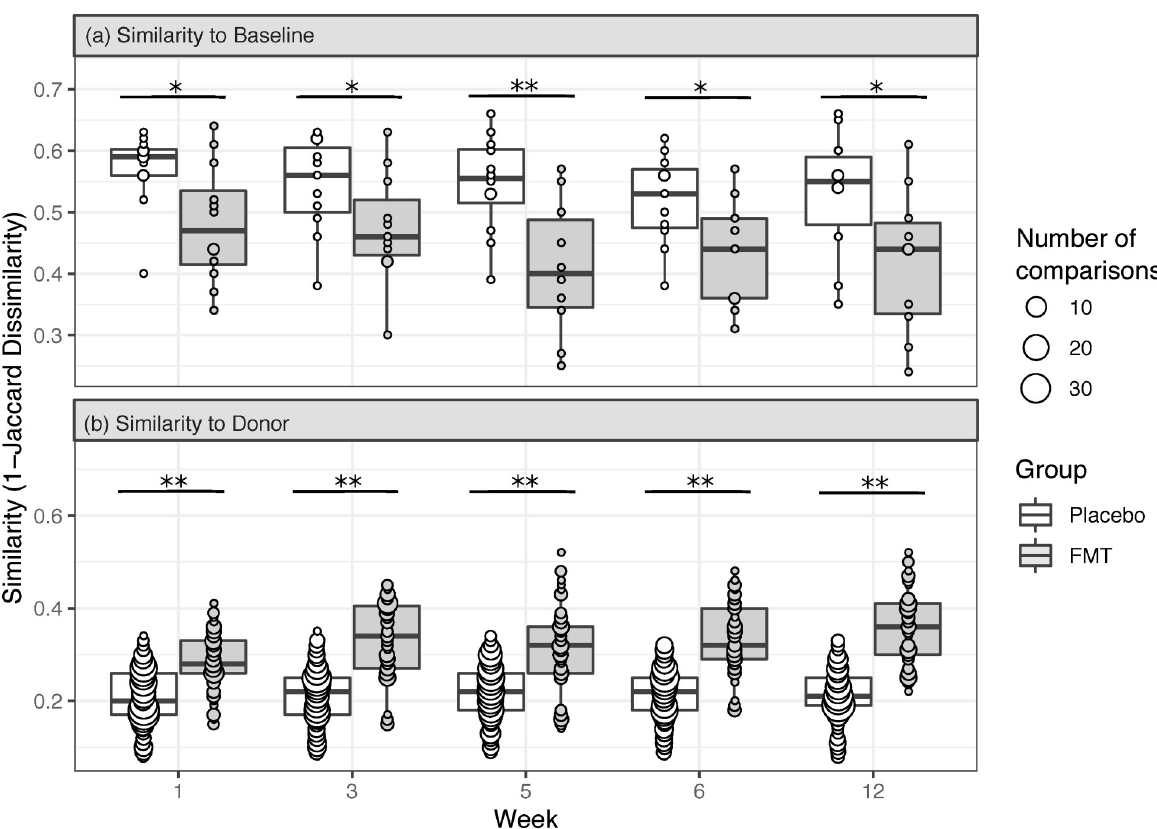
Fig 4. Beta diversity boxplots displaying microbiome compositional similarity of each participant to their respective baseline or triplicate donor preps. Microbiome similarity to baseline (a) and to donor (b) is compared between fecal microbiota transplantation (FMT) and placebo groups. Placebo results shown in (b) reflect comparisons of all combinations of placebo participant to donor prep samples. However, for Wilcoxon rank sum tests comparing similarities between FMT and placebo recipients, the similarity of each placebo participant sample to all donor prep samples was first averaged. � p < 0.05; �� p <